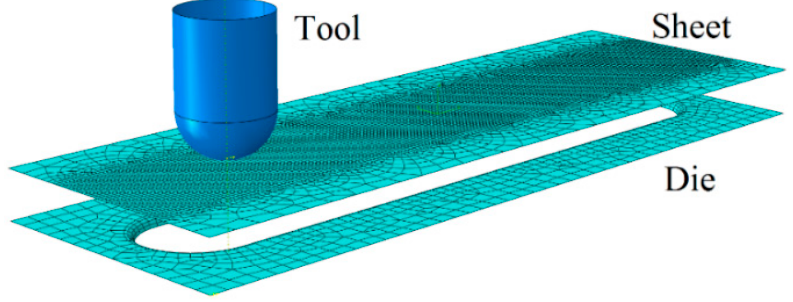
Figure 5. FEM model for incremental sheet forming.